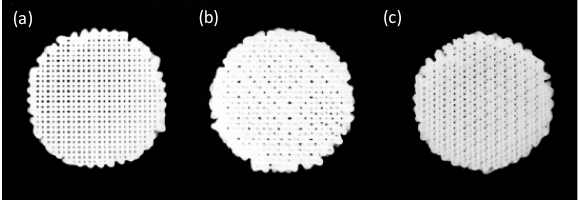
Figure 1. Three deposition angle designs fabricated with RepRap Machine. ( a ) 90° scaffold; ( b ) 45° scaffold; and ( c ) 60° scaffold.